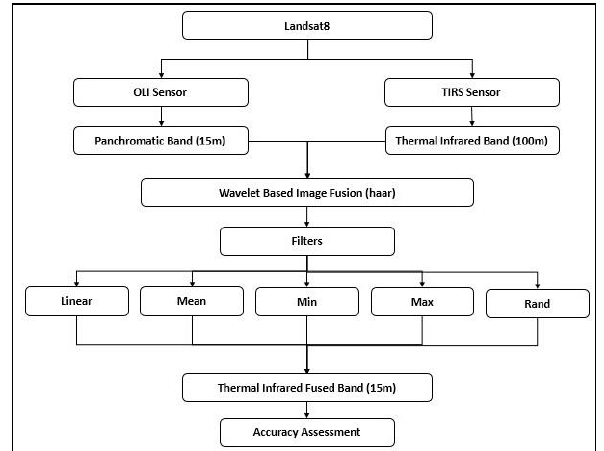
Figure 1. General structure of this paper METHODOLY WAVELET THEORY